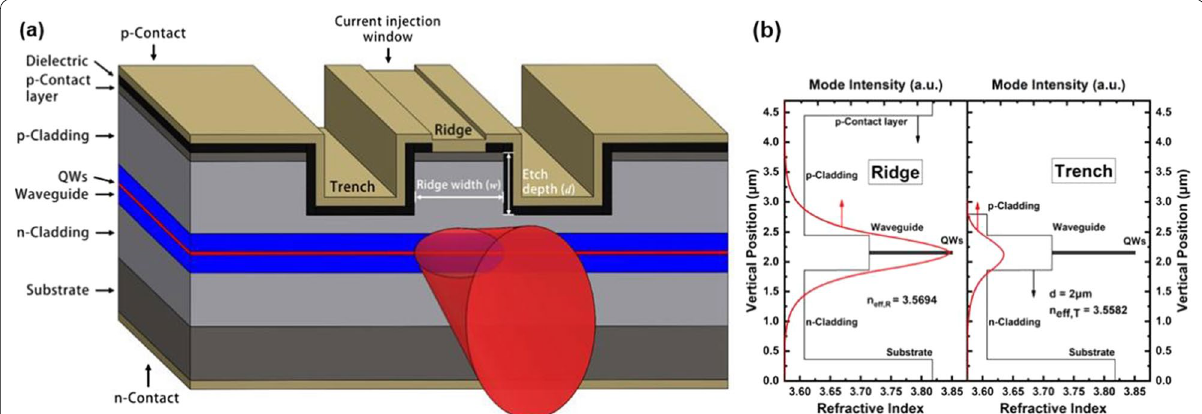
Fig. 1 a Schematic illustration of the GaSb-based epitaxial layer and narrow RW structures under investigation. b Vertical refractive index profiles of the epitaxial structure in the ridge and trench regions with simulated near-field distributions and calculated effective indices of the fundamental